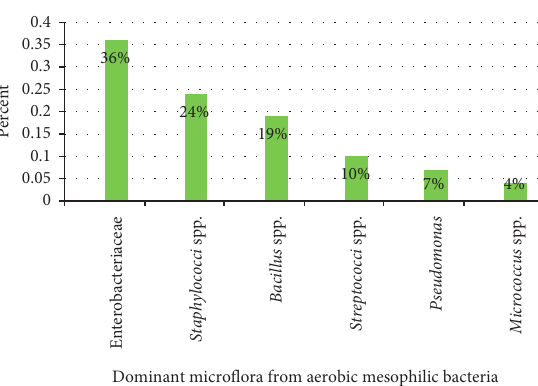
Figure 2: Dominant bacterial genera from aerobic mesophilic